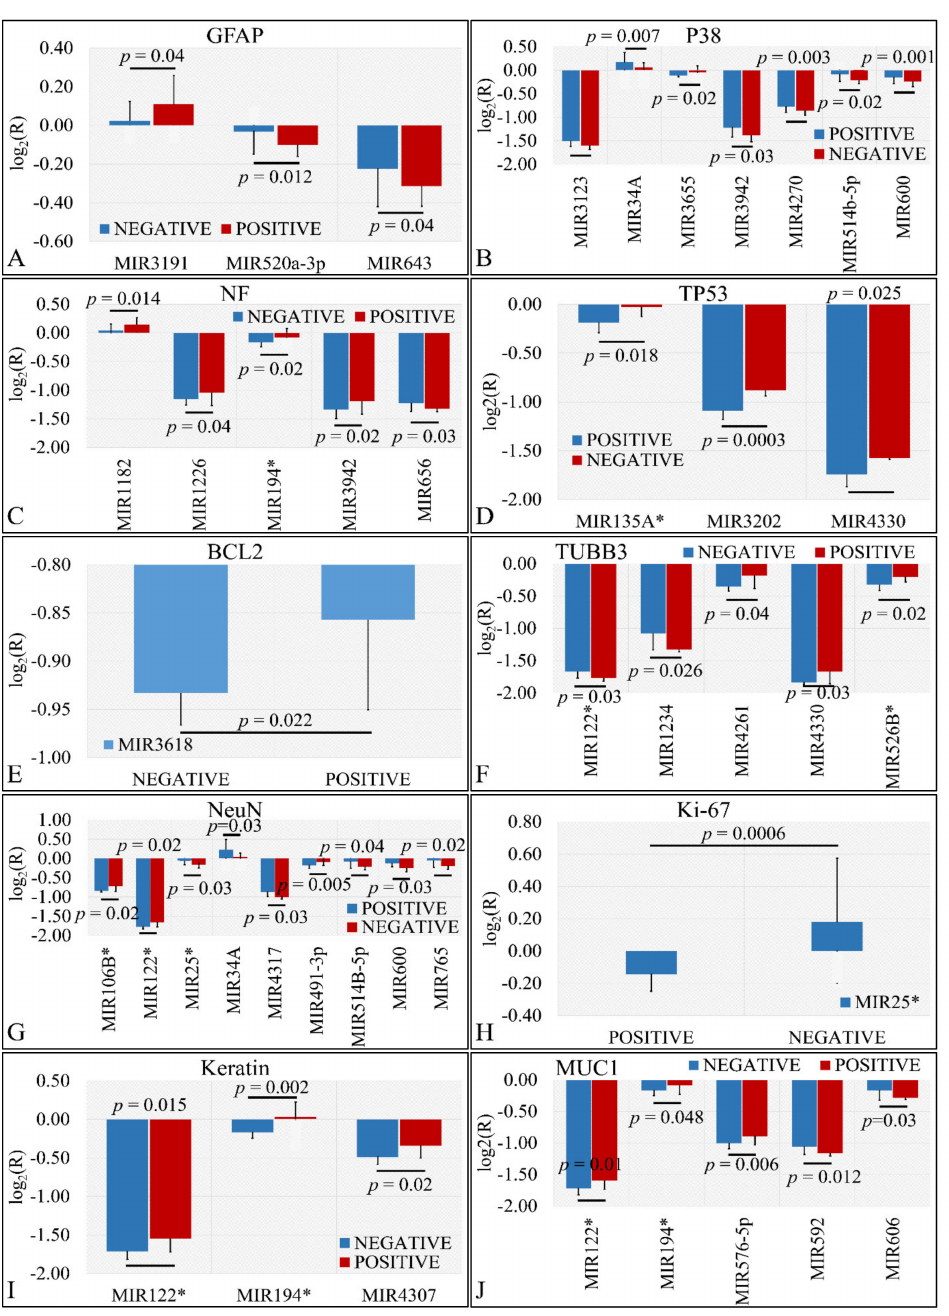
and E is the E controls